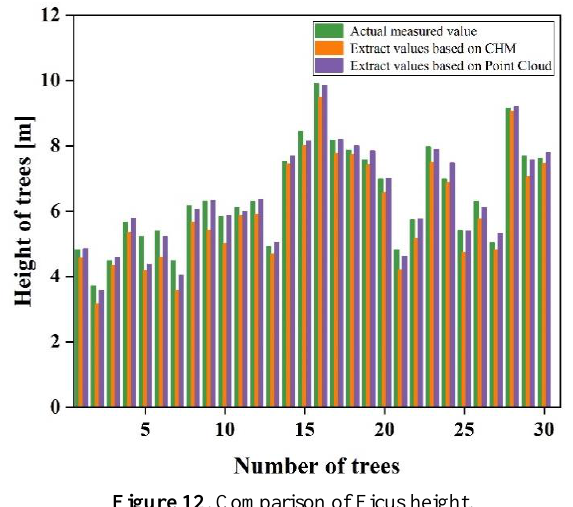
Figure 12 . Comparison of Ficus height.